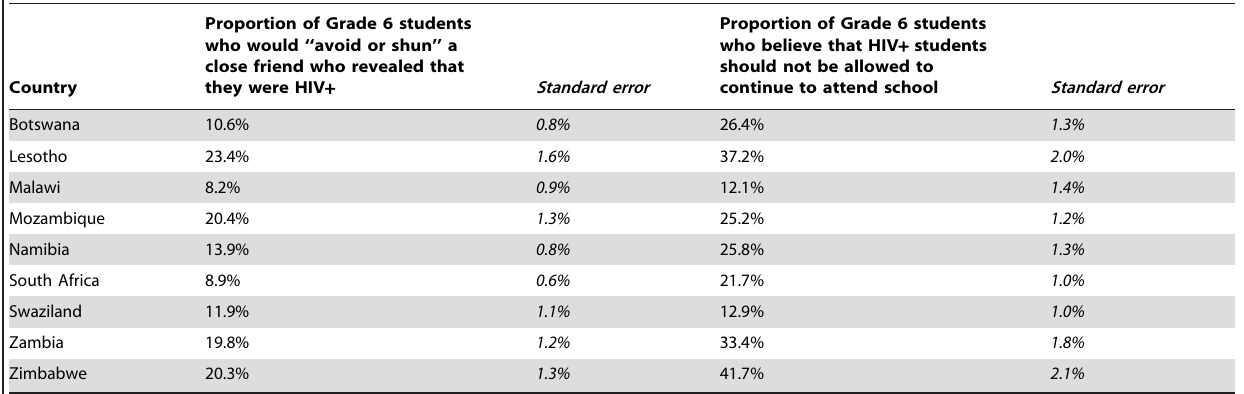
Table 2. Levels of HIV discrimination by country.